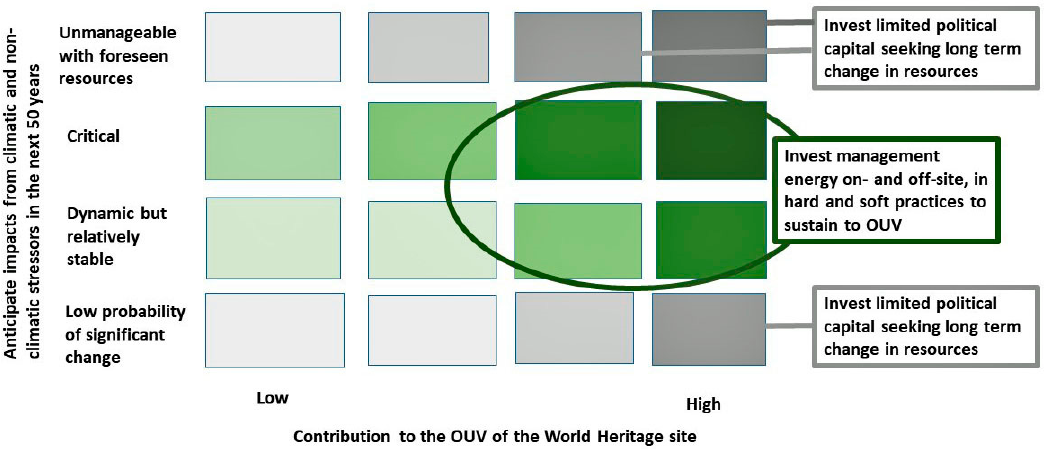
Figure 3. A risk triage for managing the OUV of a NWH site. Modified from [38]. For example, a strategy in the lower right (low risk, high value) might be to expand the boundaries of the site, a low probability effort that would require significant time and energy. Strategies in the upper right represent high value attributes that probably cannot be saved (e.g., eroding coastlines). This approach recognizes that valuable resources (i.e., upper right corner) will be lost without additional resources, but argues that long term sustainability of the OUV comes from investment in the right center. Examples of such investments might include wildlife corridors to connect patches, or no-take marine protected zones for reproduction.